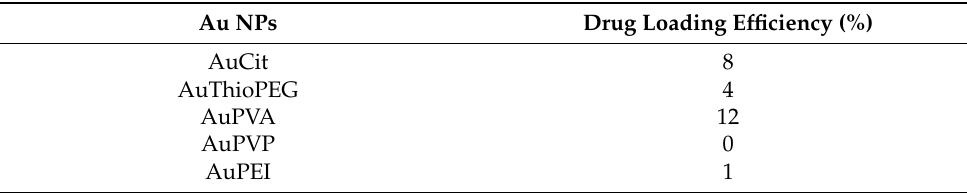
Table 1. Drug loading efficiency of Au NPs a .